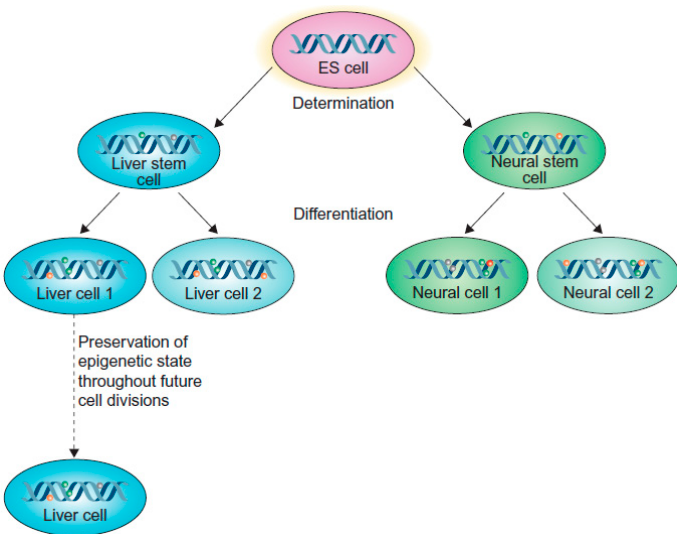
Figure 1. Epigenetic memory at the cellular level. Epigenetic memory is maintained during differentiation of neurons and liver cells from the precursor embryonic cells (adopted from [19] Copyright 2013 with permission from Elsevier).